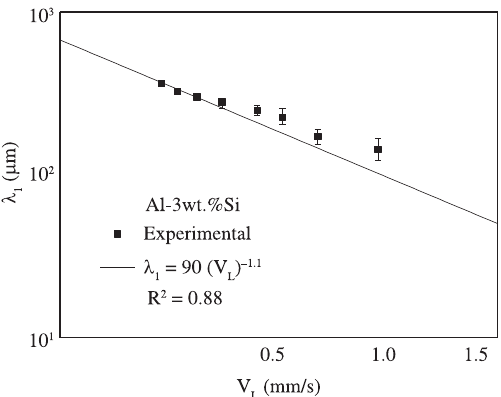
Figure 12. Primary dendrite arm spacing as a function of tip growth rate for the Al- 3wt.%Si